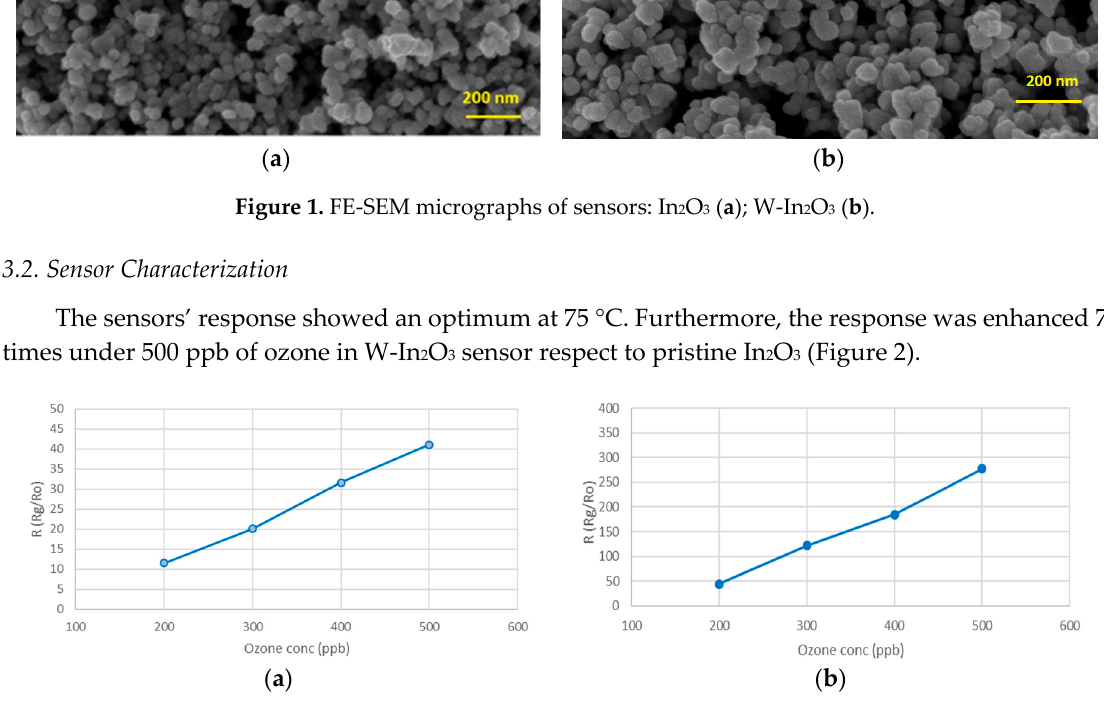
Figure 2. Sensor response as a function of ozone concentration: pure In 2 O 3 ( a ); W-In 2 O 3 ( b ).